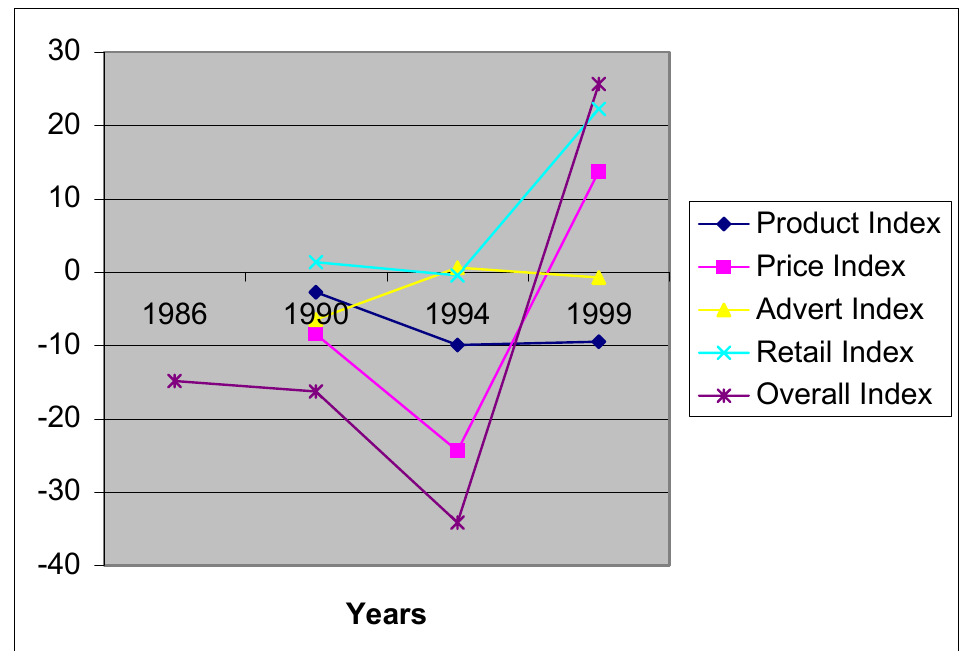
Figure 1: Components of the Marketing